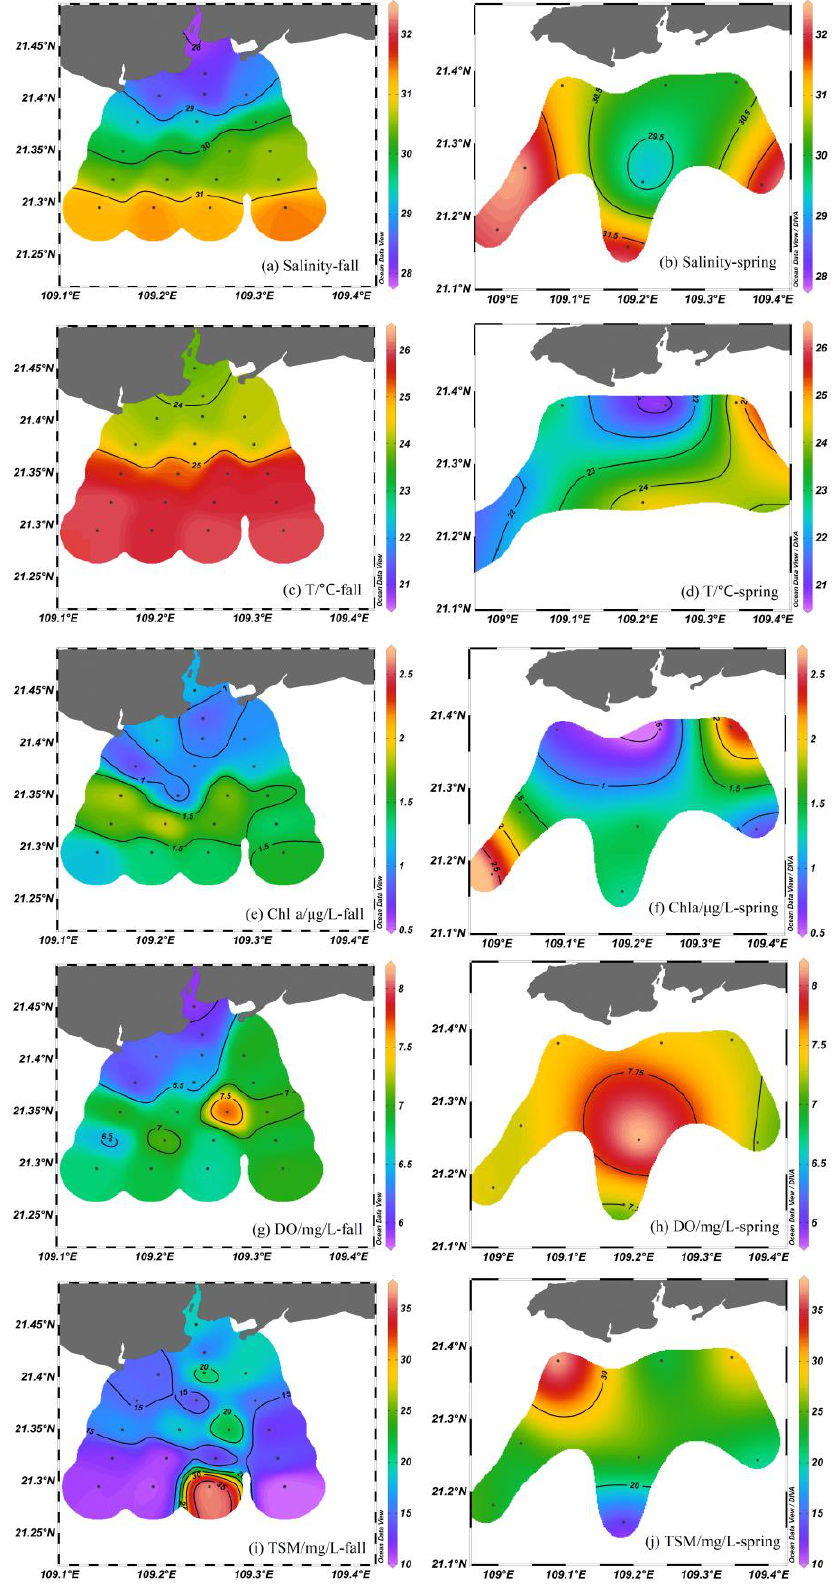
Figure 2. Spatial distributions of ( a , b ) salinity, ( c , d ) temperature, ( e , f ) Chl a, ( g , h ) DO, and ( i,j ) TSPM during the different seasons in the north-east Beibu Gulf, China.